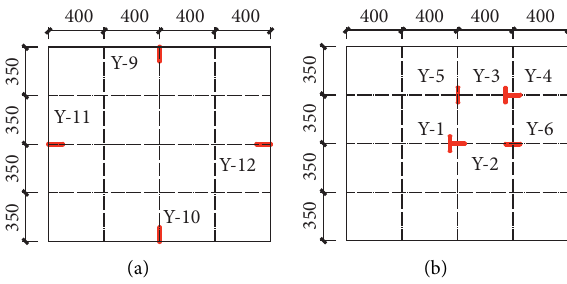
Figure 6: Layout of concrete strain gauge: (a) top of the slab; (b) bottom of the slab.